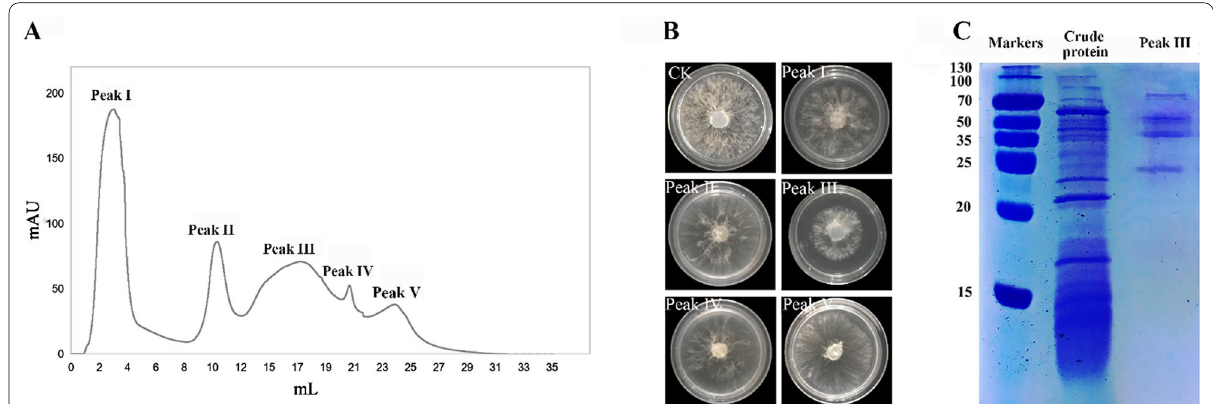
Fig. 3 Isolation of antagonistic protein in the fermentation broth of B. pumilus HR10. A Elution curve of crude protein in B. pumilus HR10 fermentation broth by strong Ion‑Exchange Chromatography; B The antagonistic activity of each elution peak; C The SDS‑PEGE stained graph of elution peak III